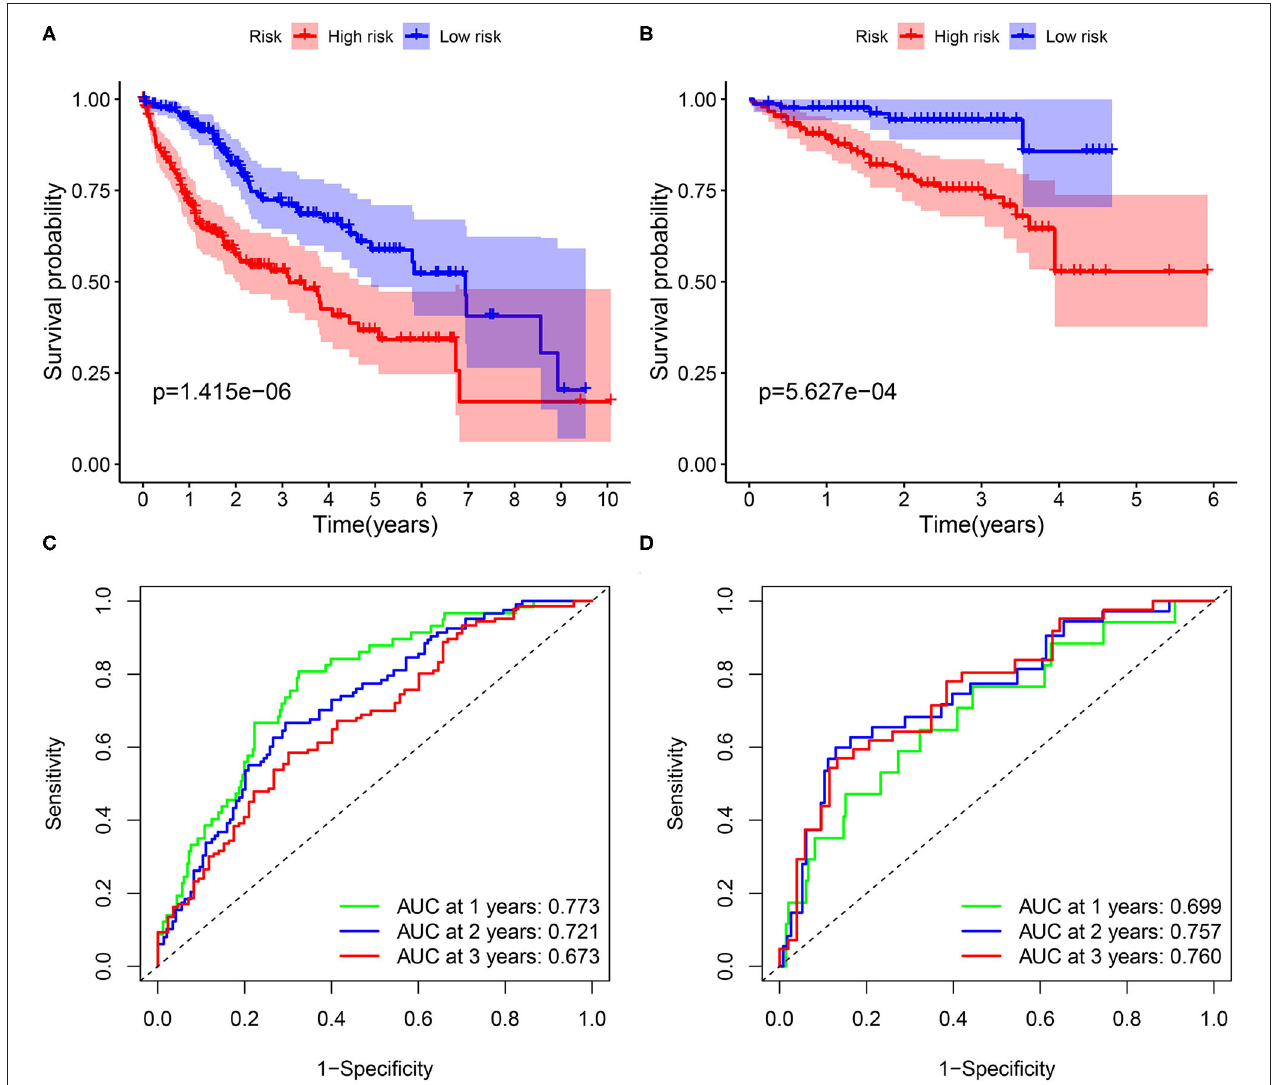
FIGURE 3 | The Kaplan–Meier analysis and the construction of prognostic model based on FABP5 , MAPT , BIRC5 , PLXNA1 , and SPP1 genes. The survival curves in the (A) training cohort and (B) validation cohort. The 1-, 2-, and 3-year receiver operating characteristic (ROC) curves for assessing the prognostic performance of the gene signature in (C) The Cancer Genome Atlas (TCGA) dataset and (D) the International Cancer Genome Consortium (ICGC)